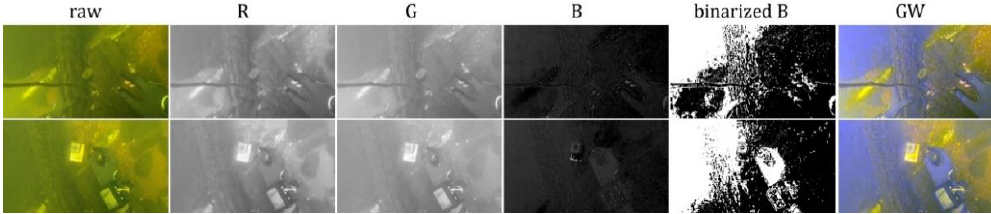
Figure 14. Blueish artifacts produced by conventional color correction method. From left to right are raw underwater images, R channels, G channels, B channels, binarized B channels and the results of gray-world (GW) method.